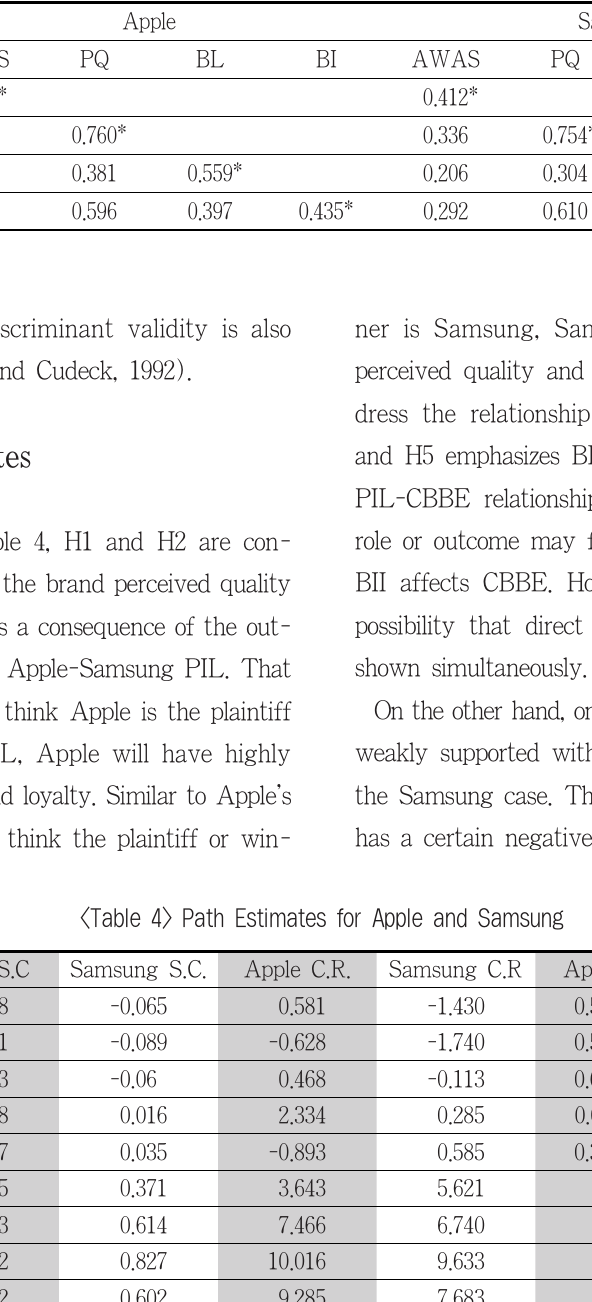
<Table 3> Discriminant Validity for Apple and